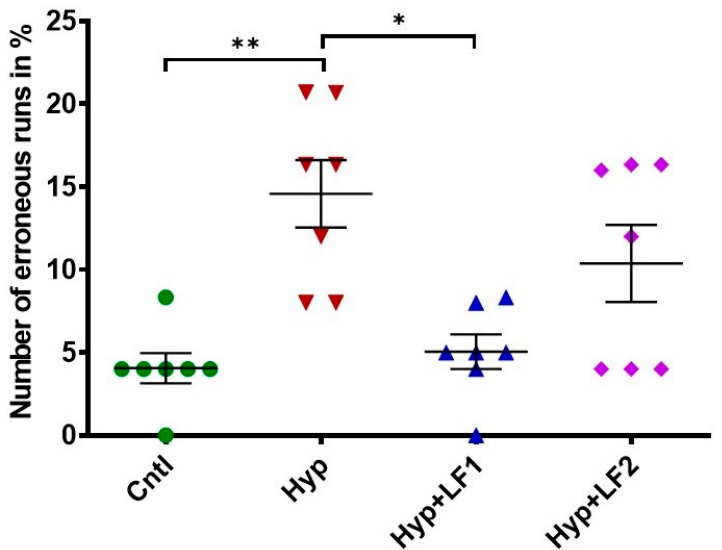
Figure 5. Effect of apo-rhLF on the working short-term memory of adult offspring (P90) tested in the two-level, eight-arm radial maze. Ordinate: number of erroneous runs in % (mean ± SEM). *— p ≤ 0.05; **— p ≤ 0.01—difference between Hyp and other groups (one-way ANOVA: F 3,27 = 8.064, p = 0.001, Tukey–Kramer post hoc test). The number of animals in each group is specified in the Methods.